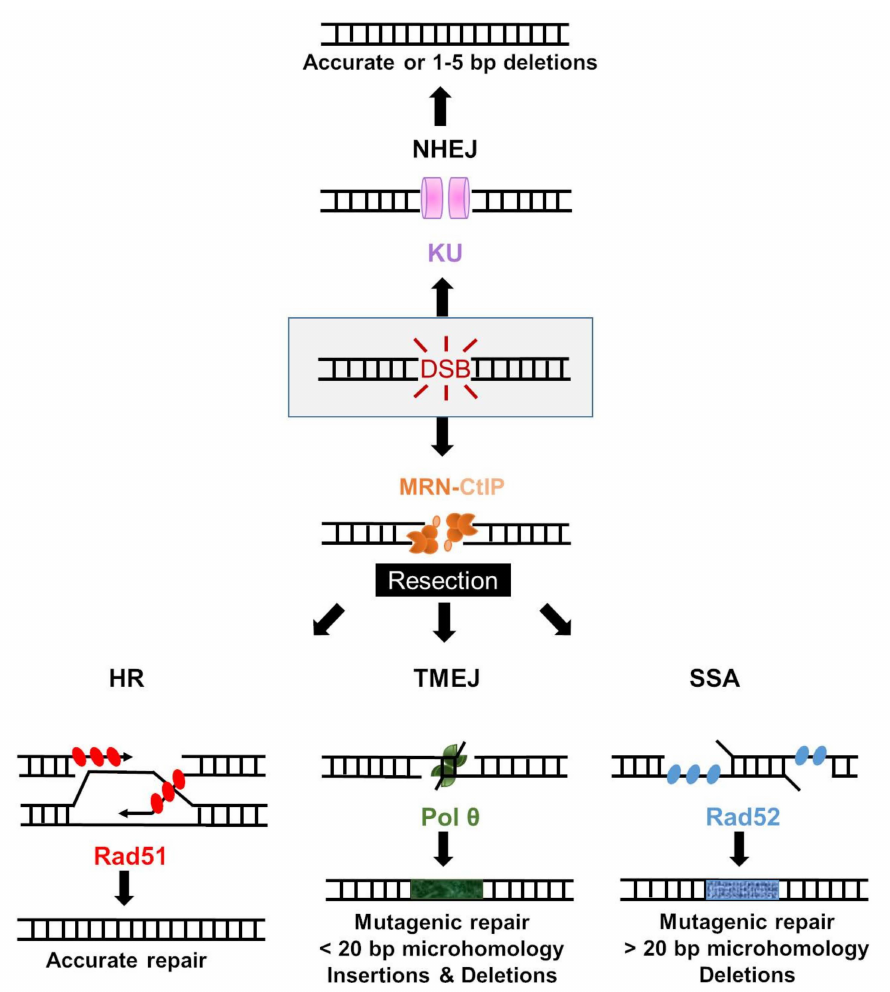
Figure 2. Major double-strand break (DSB) repair pathways in human cells. DSBs in G1 of the cell cycle are primarily repaired by non-homologous end joining (NHEJ) (Top). This pathway is initiated by the Ku heterodimer, which recognizes broken DNA. NHEJ leads to repair with minimal alteration to the original sequence. DSBs in S/G2 phases are subjected to resection leading to stretches of single-stranded DNA. Resected DSBs are substrates for homologous recombination (HR) with a critical role of Rad51 leading to an accurate repair synthesis. When HR is defective (for example when BRCA genes are mutated), an alternative pathway named Pol theta-mediated end-joining (TMEJ) can act as a back-up repair pathway. Pol θ promotes the synapsis of the